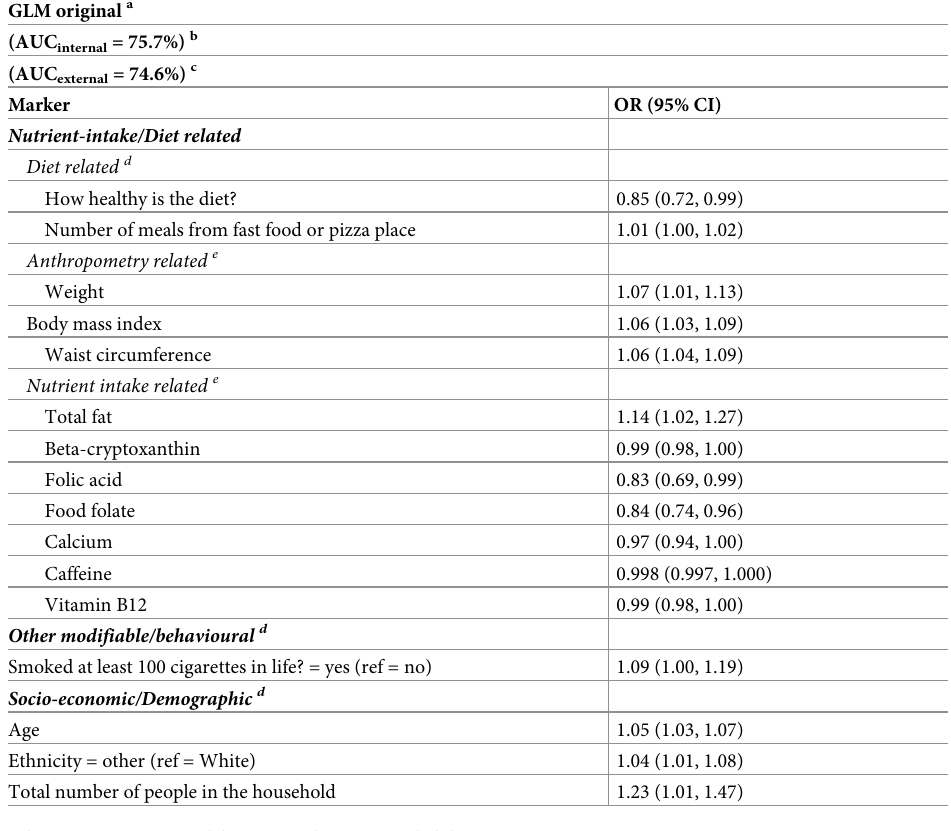
Table 1. Nutritional and other markers of undiagnosed type 2 diabetes identified by the best-performing logistic model (AUC = 75.7%). GLM original